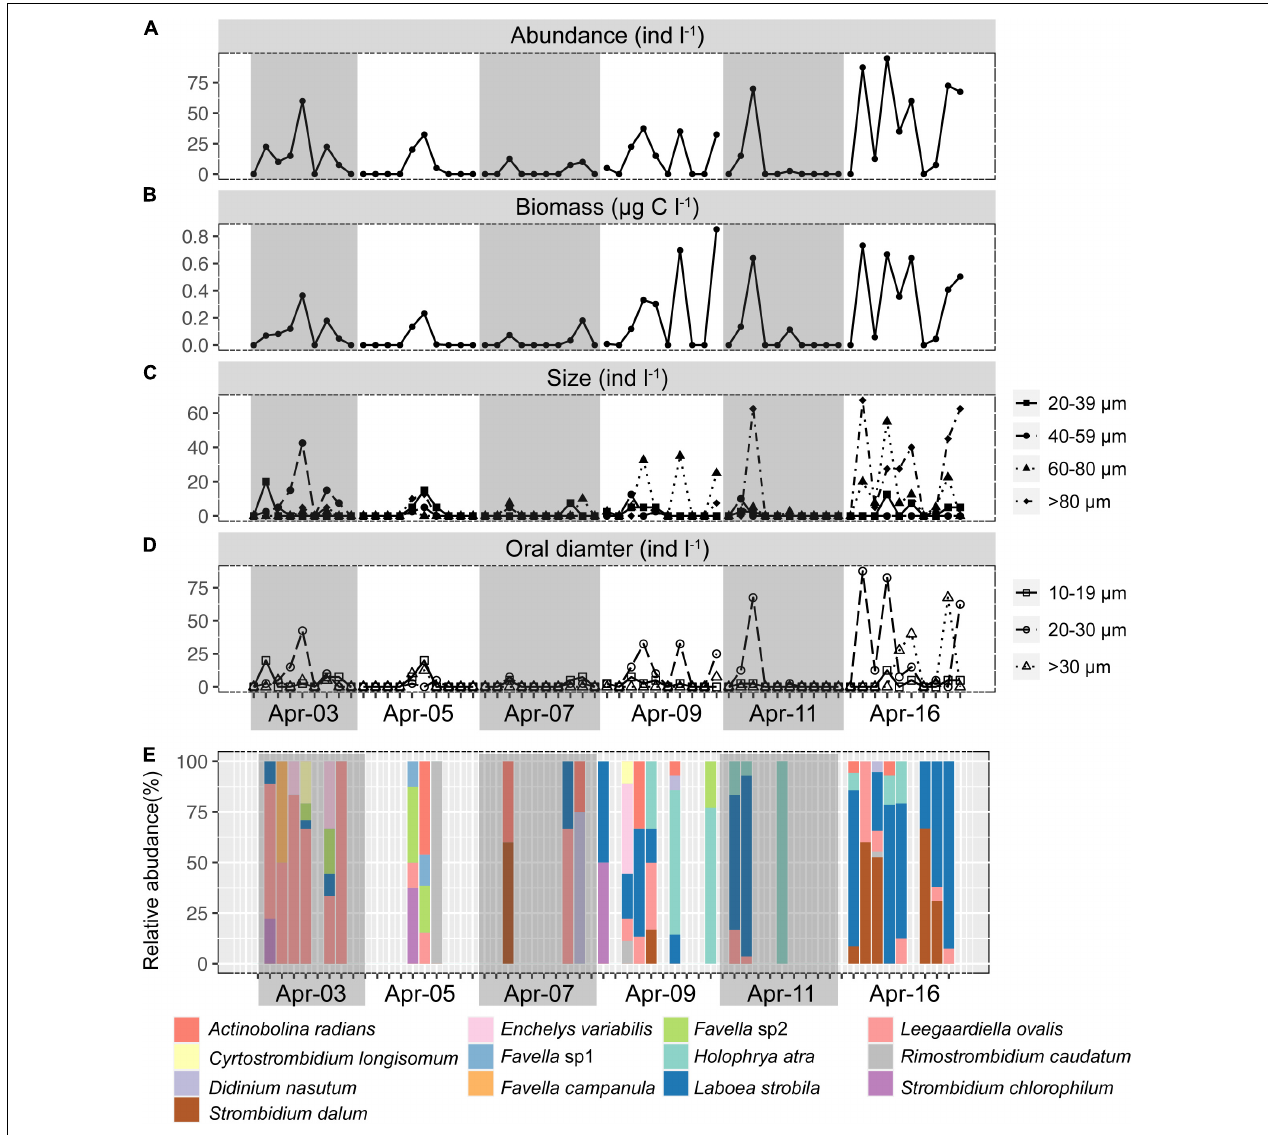
FIGURE 2 | Short-term time series of the abundance (A) , biomass (B) , size structure (C) , oral diameter structure (D) , and community composition of ciliates (E) . Gray or non-gray shadow represented different sampling days.